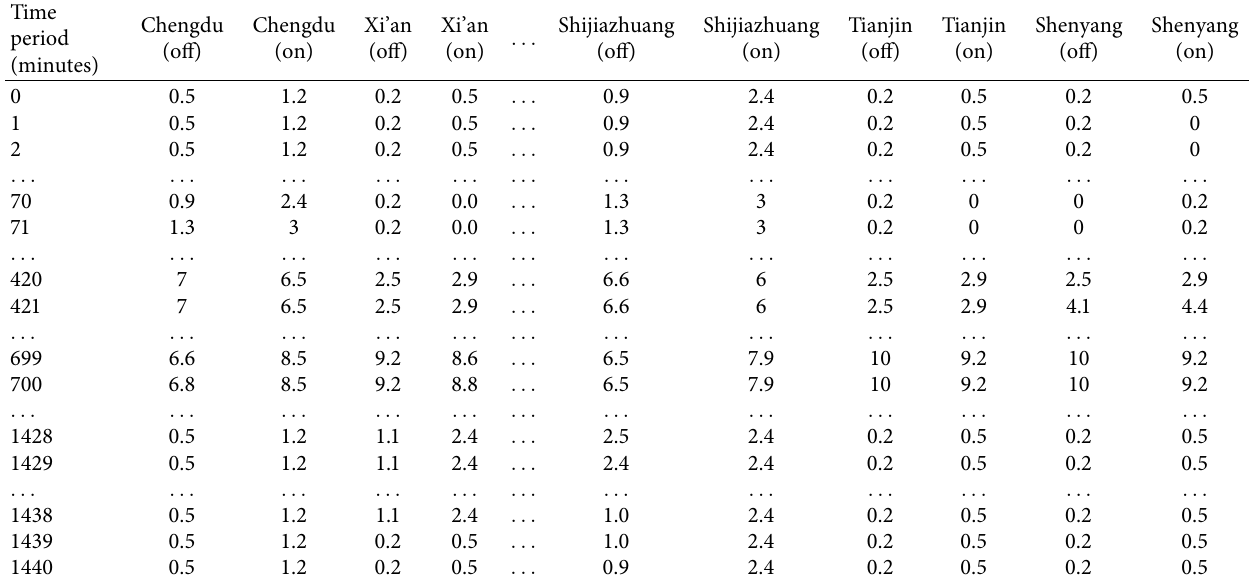
Table 2: Passenger satisfaction of getting on and off at all stations along the route throughout the day. Time period